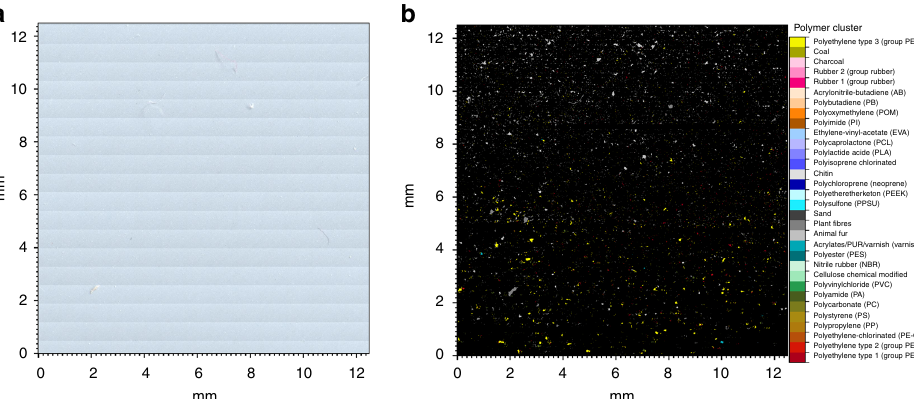
Fig. 2 Images of the microplastic analysis. a Overview image collected by the fourier-transform infrared imaging (FTIR) microscope prior to measurement. b Polymer dependent false-colour image of an exemplary measurement fi eld after FTIR measurement and automated